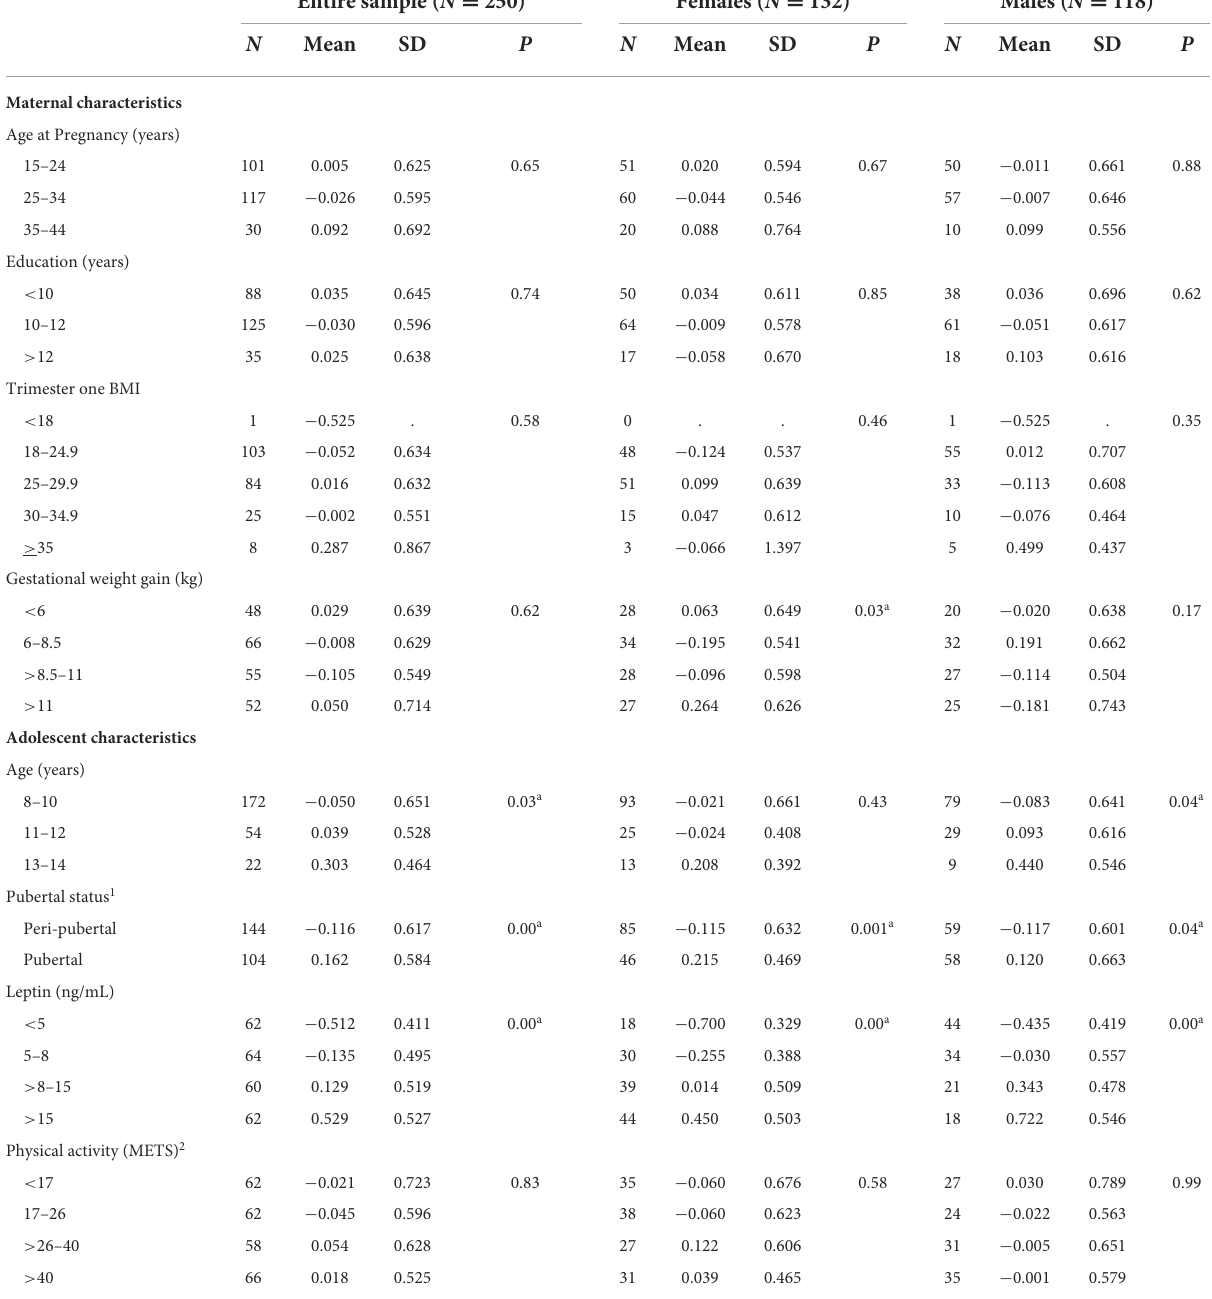
TABLE 1 Differences in the distribution of adolescent metabolic syndrome risk scores ( − 2 to 2) across maternal and adolescent sociodemographic